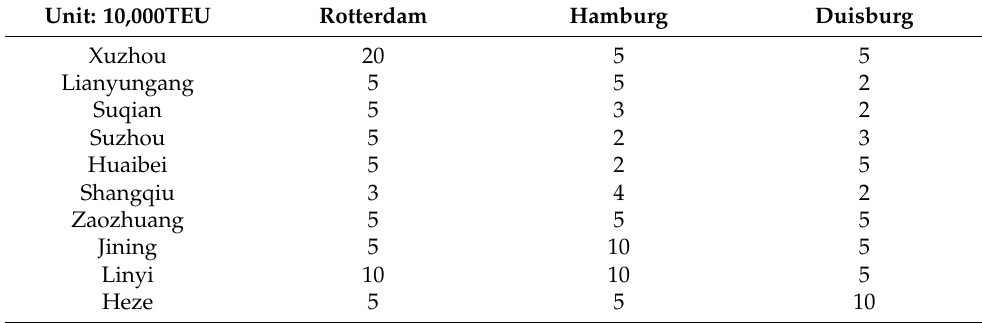
Table 4. Cross-border transportation demand for different cities in Huaihai Economic Zone. Unit: